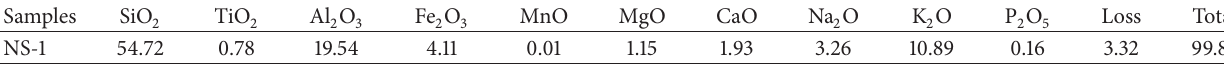
Table 1: Chemical composition of natrolite syenite powder (wt%).